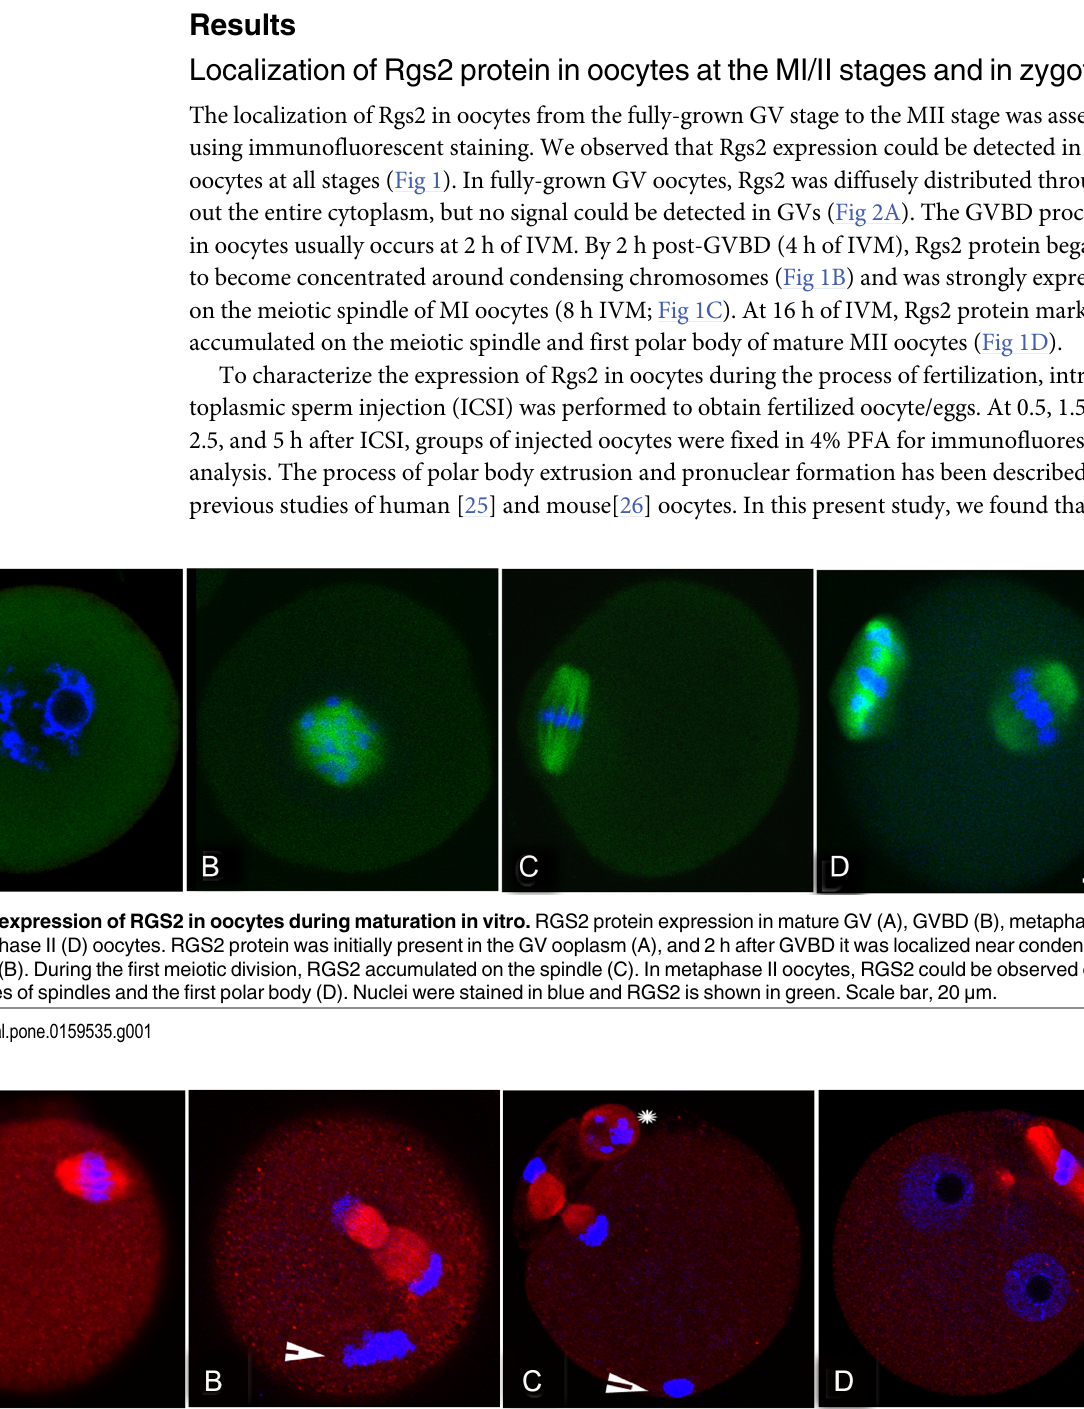
Fig 2. Localization of RGS2 proteins in ICSI oocytes and pronuclear zygotes. RGS2 accumulated on the spindle and sperm DNA (arrow) during meiosis II did not change 30 min after a sperm head was injected into a MII oocyte. By 1 h later, the oocyte had entered the anaphase/ telophase stage and RGS2 had become ‘ stretched ’ to the opposite direction (B). At 2.5 h after ICSI, the second polar body was extruded, and RGS2 was strongly stained in the spindle of fertilized eggs and the second polar body (C). By 5 h after the sperm entered the oocyte, two pronuclei had formed and RGS2 was only present in the zygote cytoplasm and second polar body, but not in pronuclei. Nuclei are stained blue and RGS2 is shown in red. Scale bar, 20 μ m.